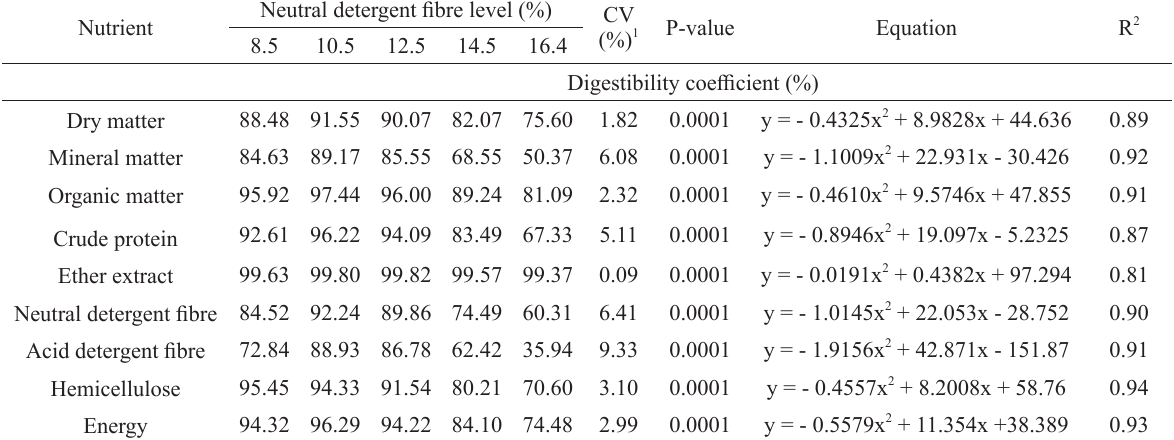
Digestibility coefficients of nutrients and energy from diets containing different levels of NDF for piglets in the nursery